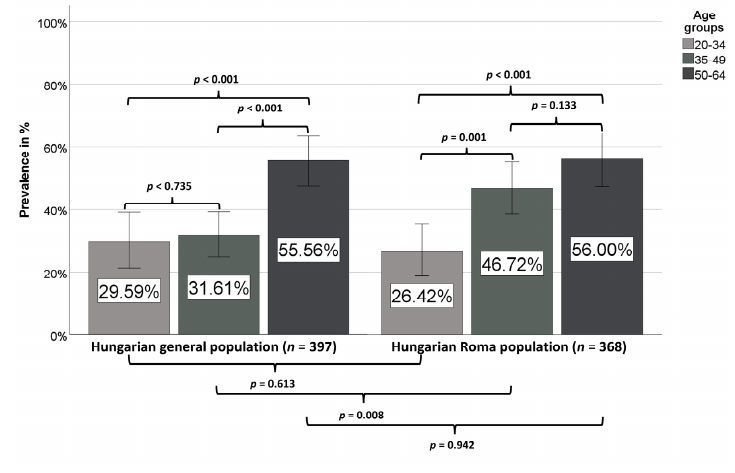
Table 4. Average surrogate index values calculated for the Hungarian general (HG) and Hungarian Roma (HR) populations. Without MetS With MetS HG HR HG Indices p -Value ( n = 397) ( n = 368) ( n = 239) HOMA-IR